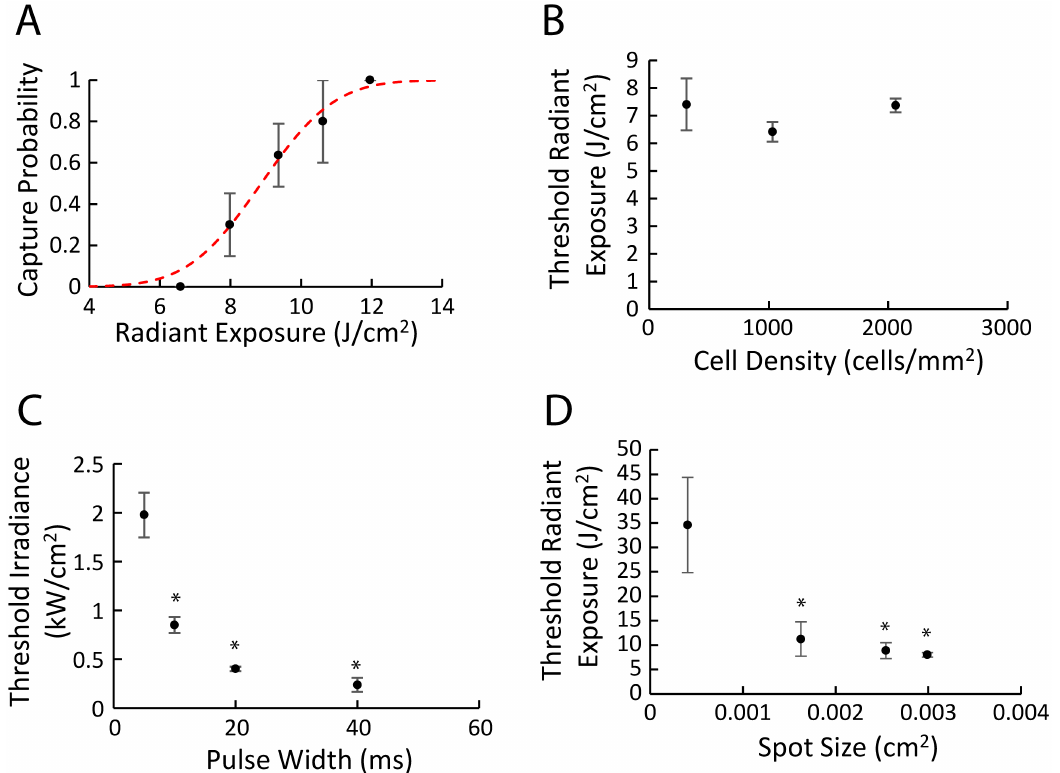
Fig 3. Measurement of threshold energies for optical pacing. (A) Assessment of threshold by a search pattern through a fixed number of monolayers, N = 30 total. To comparethreshold under different conditions, 50% capture probabilitywas calculated(see text for details). (B) Cell density at three different values (3.1 x 10 2 , 1.0 x 10 3 and 2.0 x 10 3 cells/mm 2 ), N = 30 for each point. (C) Pulse widths were varied between5 ms and 40 ms, N = 18 for each point. (D) Spot size was varied between4 x 10 − 4 and 2.9 x 10 − 3 cm 2 , N = 30 for each point. Thresholdsrequiredto achieve 50% pacing probabilityare plotted againstradiant exposureper pulse (B, D) and irradiance(C). Error bars reflect the standarderror (A) and standarddeviation(B-D). In panelsC and D, * indicatesa statistically significance(p < 0.001) decrease comparedto the smallest pulse width and spot